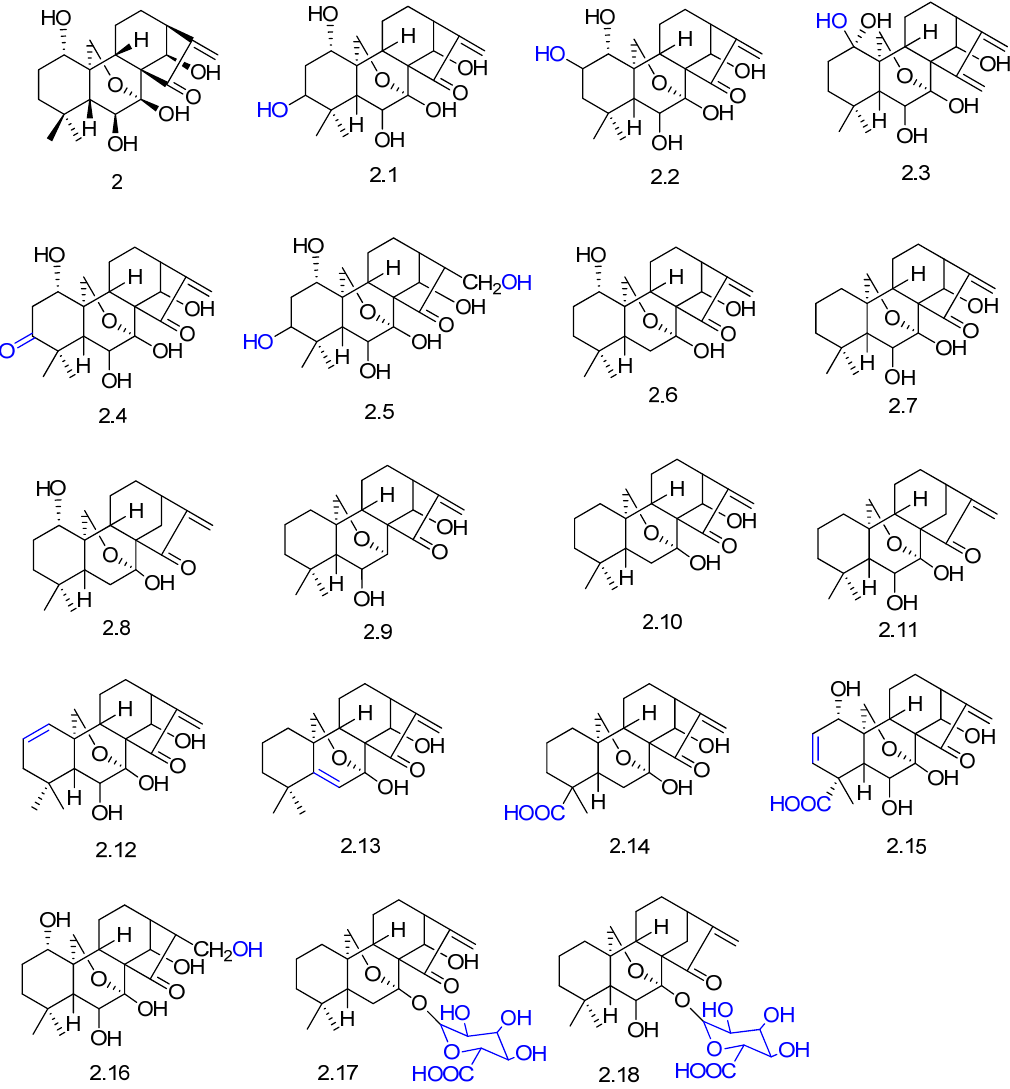
Figure 4. Proposed chemical structures of oridonin ( 2 ) metabolites in rats in vivo [50].